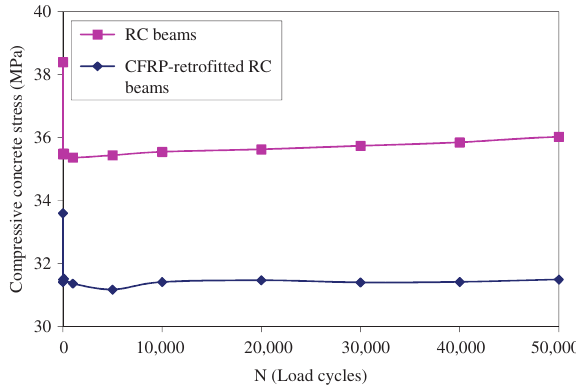
Figure 7: Experimental measurements of the maximum compressive stress for concrete versus load cycle